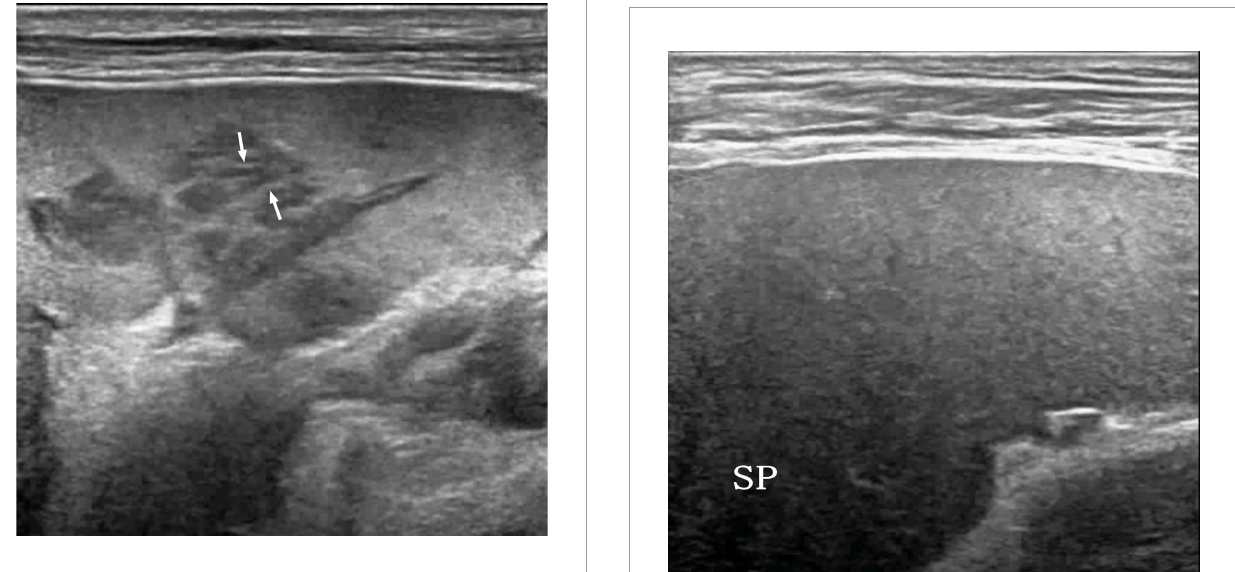
FIGURE 1 | A 67-year-old man with splenic lymphoma. Multiple hypoechoic nodules are visible in the splenic region. Some of the nodules are fused with each other. Striations in the hyperechoic areas are observed in the nodule (arrow).